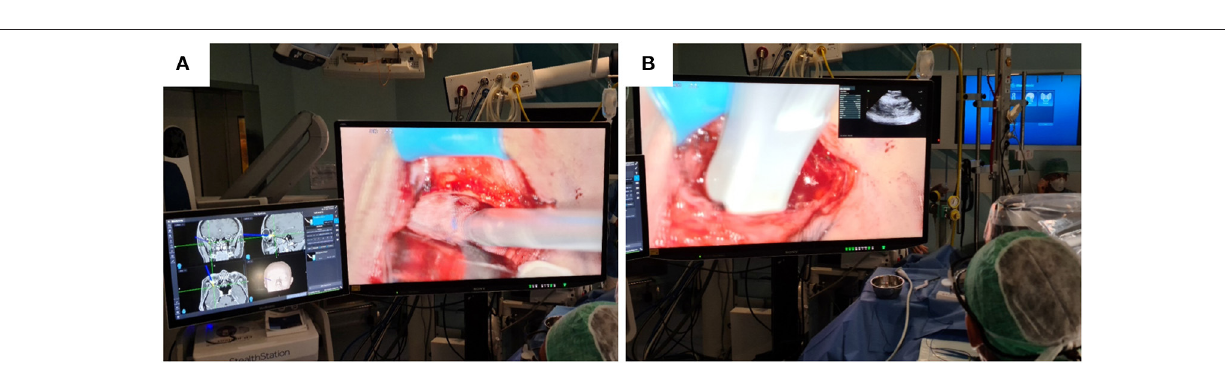
FIGURE 2 | On the 55-inch monitor, the navigation device (A) and ultrasound probe (B) used for precise localization of the hemangioma inside the periorbita are clearly visible. The PiP mode (B) allows the surgeon to control the position of the ultrasound probe without having to look away from the operating